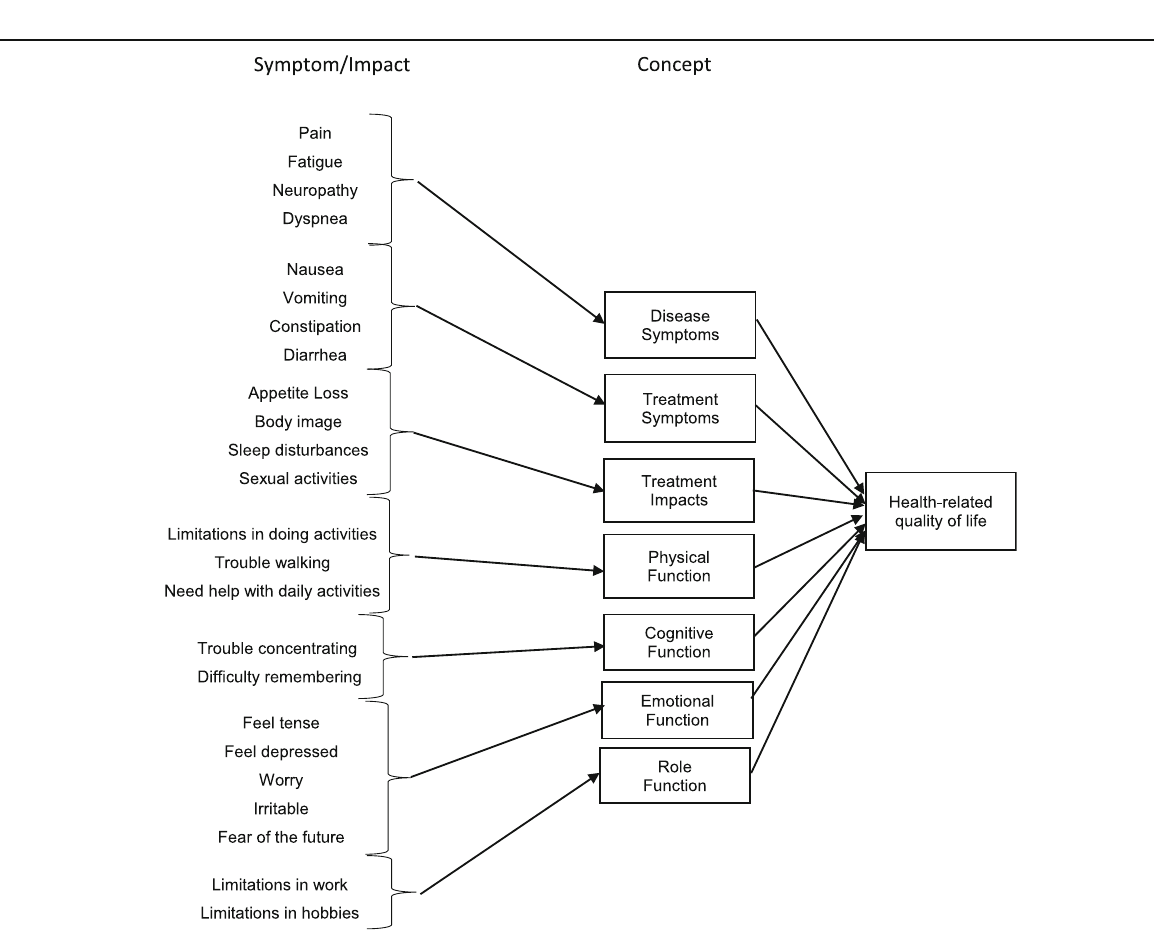
Fig. 2 Conceptual Model. Conceptual model developed based on symptoms and impacts included in existing PRO instruments, validated for use as an endpoint in MM clinical trials. Not an exhaustive report of concepts, but a representation to initiate the data search and creation of search